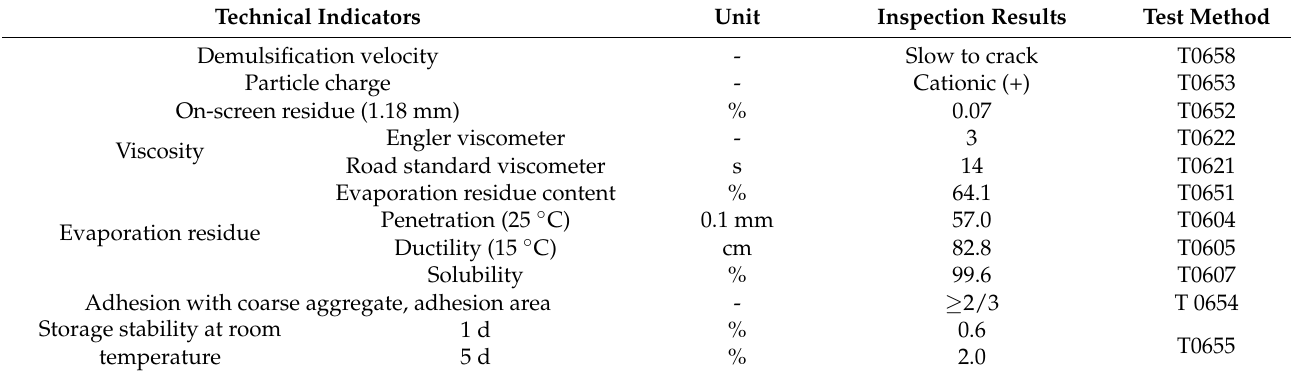
Table 4. Test results of emulsified asphalt B raw material.